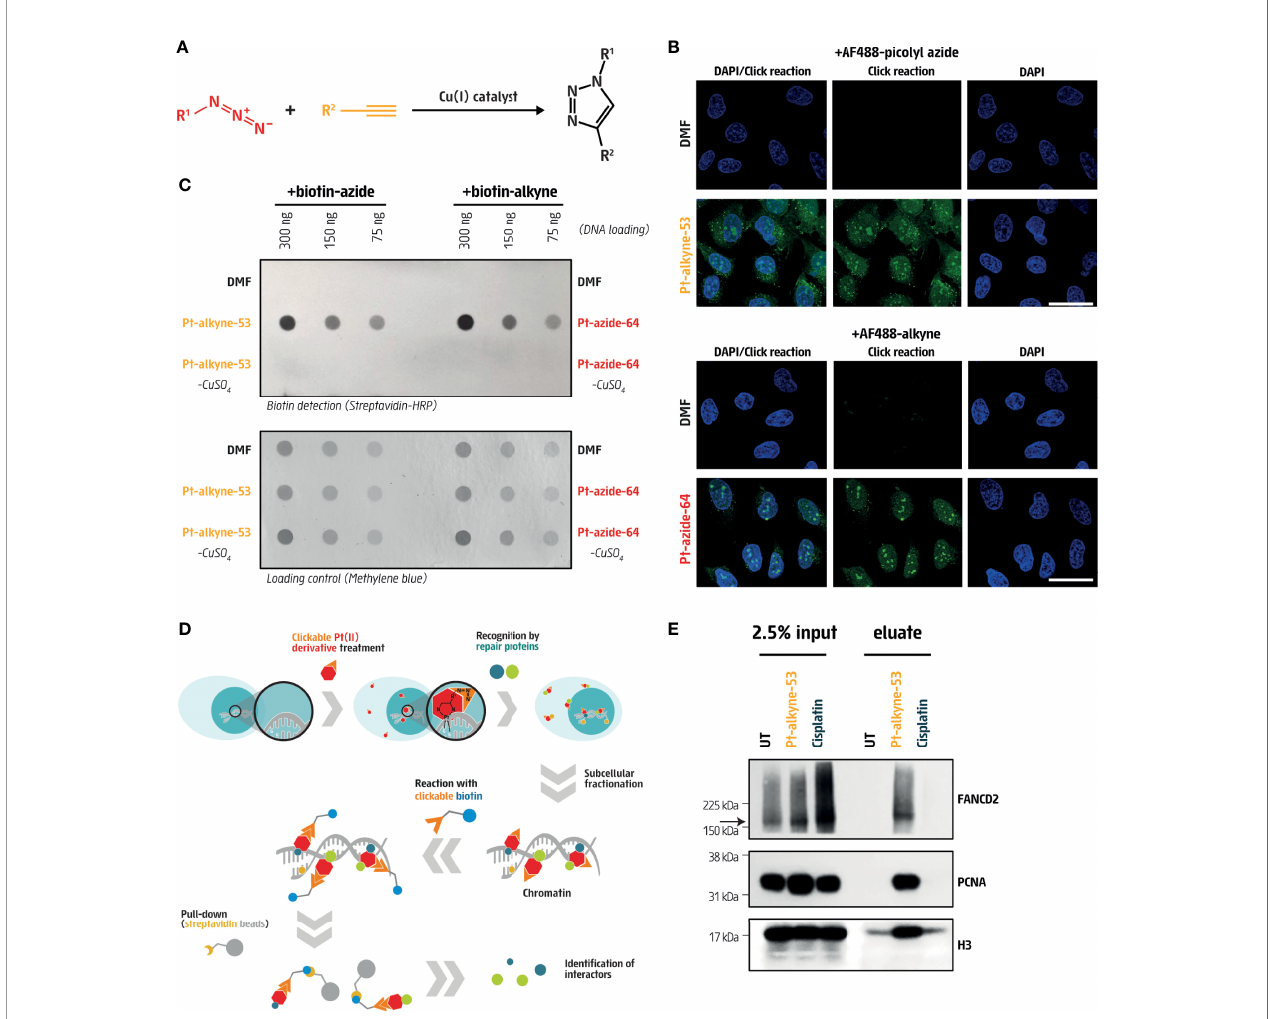
FIGURE 4 | Cisplatin derivatives are clickable and bind DNA repair proteins. (A) Schematic representation of the copper-catalyzed click reaction (CuAAC) in which an azide (purple) and an alkyne (orange) compound were covalently bound to form a triazole conjugate. (B) Visualization of clickable Pt-alkyne-53 with AF488-picolyl azide and Pt-azide-64 with AF488-alkyne in U2OS cells treated for 3 hours with the indicated compounds at 5 m M or 25 m M, respectively (green). DAPI (blue) was used to counterstain nuclei. Vehicle treated cells (DMF) were used as a negative control. Scale bar represents 20 m m. (C) Dot blot of DNA from U2OS cells, immobilized on a nitrocellulose membrane and stained with streptavidin-HRP to detect DNA-bound biotin. Cells were pre-incubated for 5 hours with 100 m M Pt-alkyne-53 or Pt-azide-64, followed by fi xation and subjected to a CuAAC click reaction with biotin-azide or biotin-alkyne. Vehicle treated cells (DMF), as well as cells exposed to the CuAAC click reaction without the copper catalyst (-CuSO 4 ), were used as negative controls. Methylene blue staining of the nitrocellulose membrane was used to control for loading. (D) Scheme of the experimental approach to pull-down DNA repair proteins that interact with the cisplatin derivatives. (E) Pull-down of Pt-alkyne-53 from U2OS cells treated with 10 m M cisplatin or 100 m M Pt-alkyne-53 for 12 hours. The CuAAC click reaction was performed with biotin-azide on chromatin fractions and streptavidin beads were used to pull down the Pt-alkyne-53 along with the proteins bound to it. Proteins enriched in chromatin fractions (input) as well as proteins pulled down with the streptavidin beads (eluate) were probed with the indicated antibodies. The arrow indicates the expected size of the FANCD2